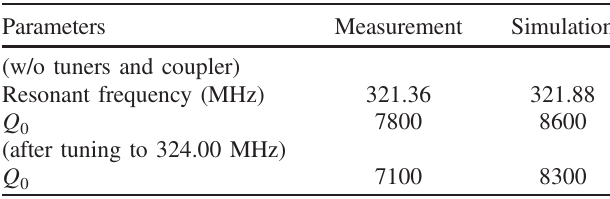
TABLE III. Result of the low-power tuning. Parameters Measurement